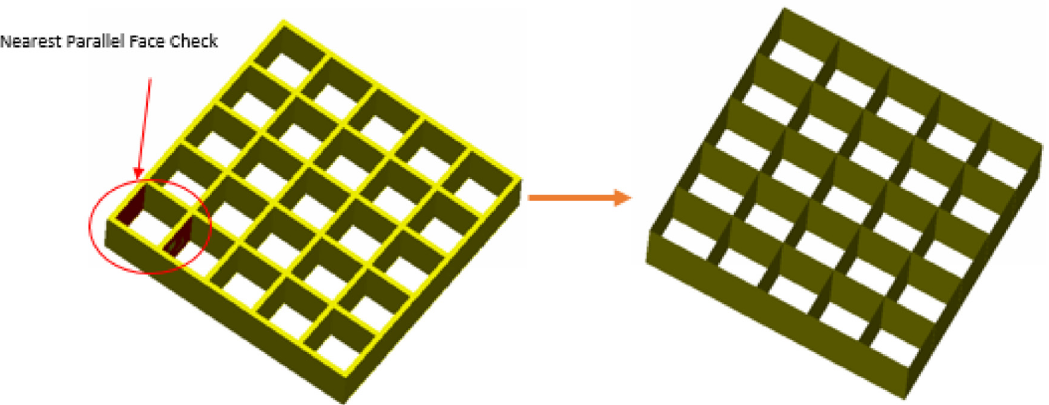
Fig. 1. Neighbour search requirement for mid-surface extraction.